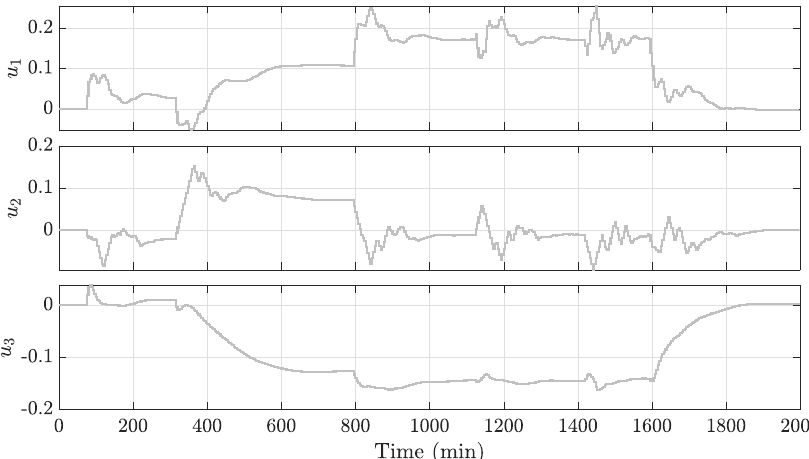
Figure 14. Case 1—Manipulated variables of the HOF with